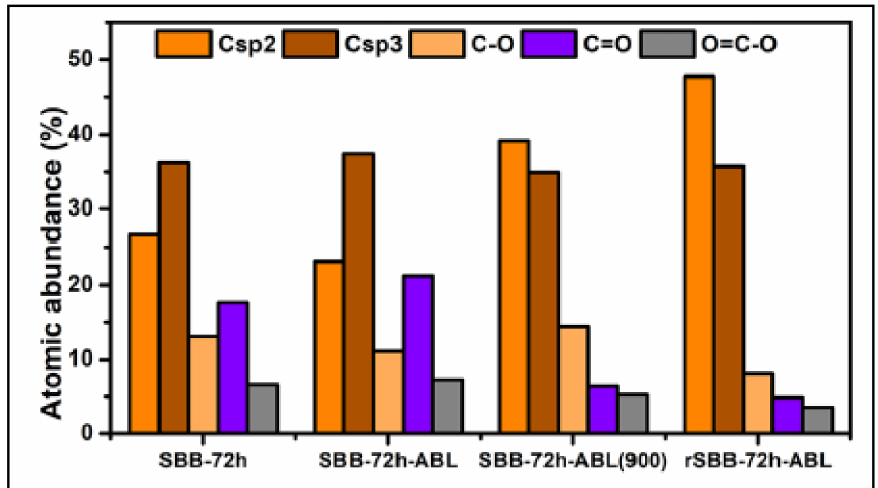
Figure 31. Carbon quantitative data of treated biochar samples